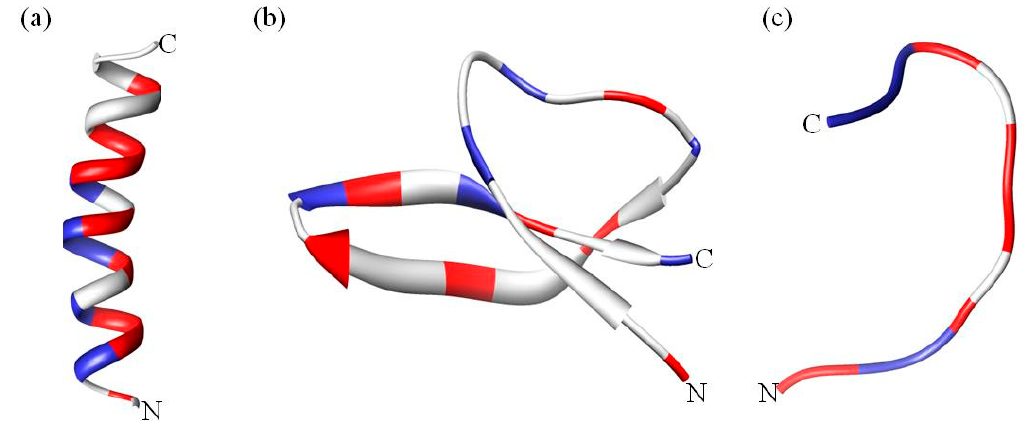
Figure 2. Structural diversity of antimicrobial peptides (AMPs). ( a ) the α helical magainin, ( b ) β sheet human defensin 5 and ( c ) extended coil indolicidin. Positively charged residues are colored blue whereas hydrophobic residues are red. The N- and C-termini are indicated. The figure was generated using CHIMERA software